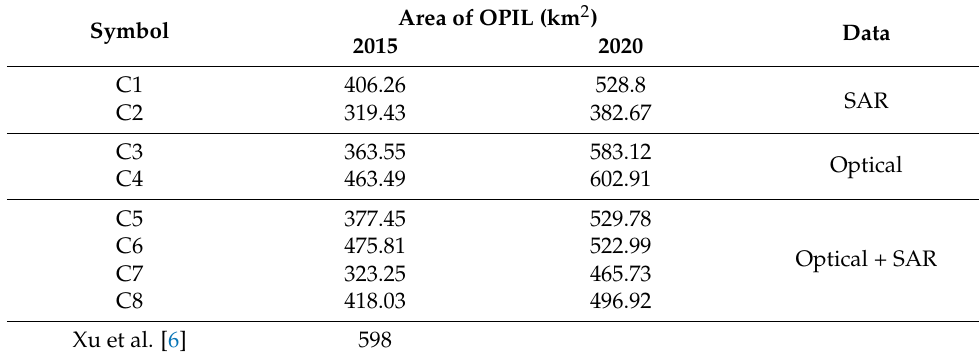
Table 5. Accuracy assessment of LULC classification.